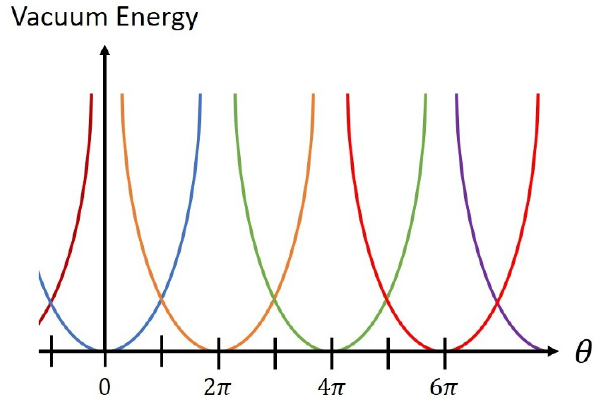
Figure 6. Expected behavior of the vacuum energy as a function of (cid:18) in a large N gauge theory. Distinct branches are shown in di(cid:11)erent